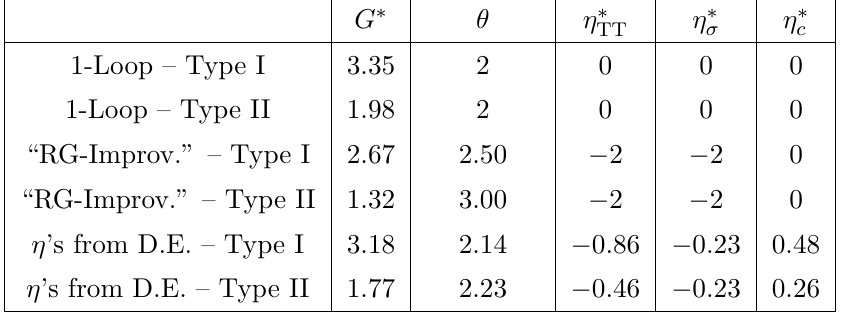
= ~ m 2 = 0. Here we report k; TT k;(cid:27)